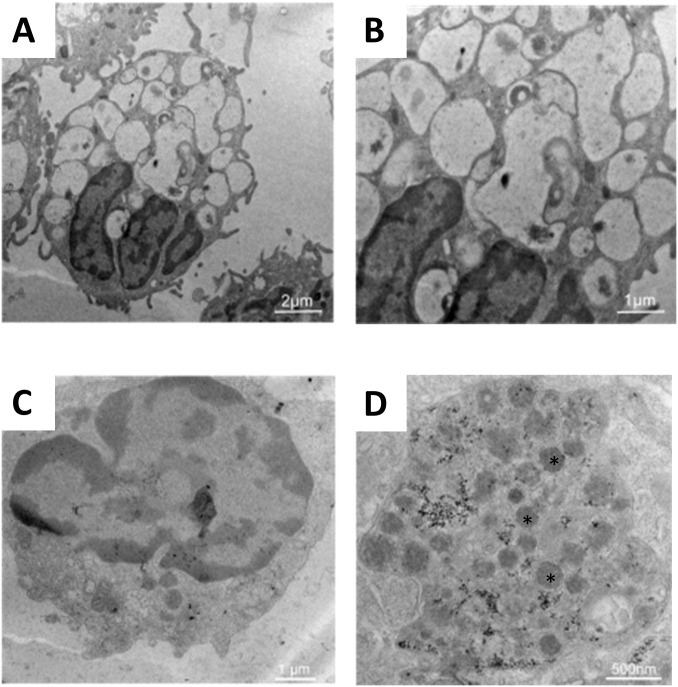
Transmission electron microscopy (TEM) evaluation of cellular uptake of PLGA NP preparations by canine macrophages.Day 7 canine macrophages cultures (1x106) were incubated with 50 μg/mL of PLGA/OVA/MPLA NPs. After 24 hours, nonadherent cells were harvested and analyzed by TEM. The macrophages without treatment (A) and (B) contain empty phagocytic vacuoles while the macrophages incubated with PLGA NP/OVA/MPLA (C) and (D) demonstrated absence of vacuoles and the presence of electron-dense material reflecting uptake of the NPs. (A) scale bar = 2 μm, (B) and (C) scale bar = 1 μm, and (D) scale bar = 500 nm. Similar data were obtained in three independent experiments.